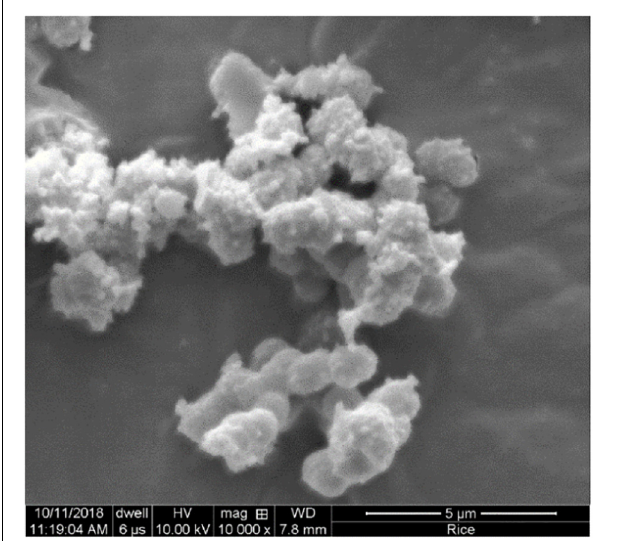
FIGURE 3 | SEM image of Ca-DTPMP particles prepared without adding